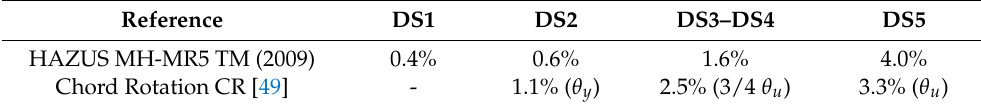
Table 2. IDR damage states thresholds (%) as a function of the different criteria considered.